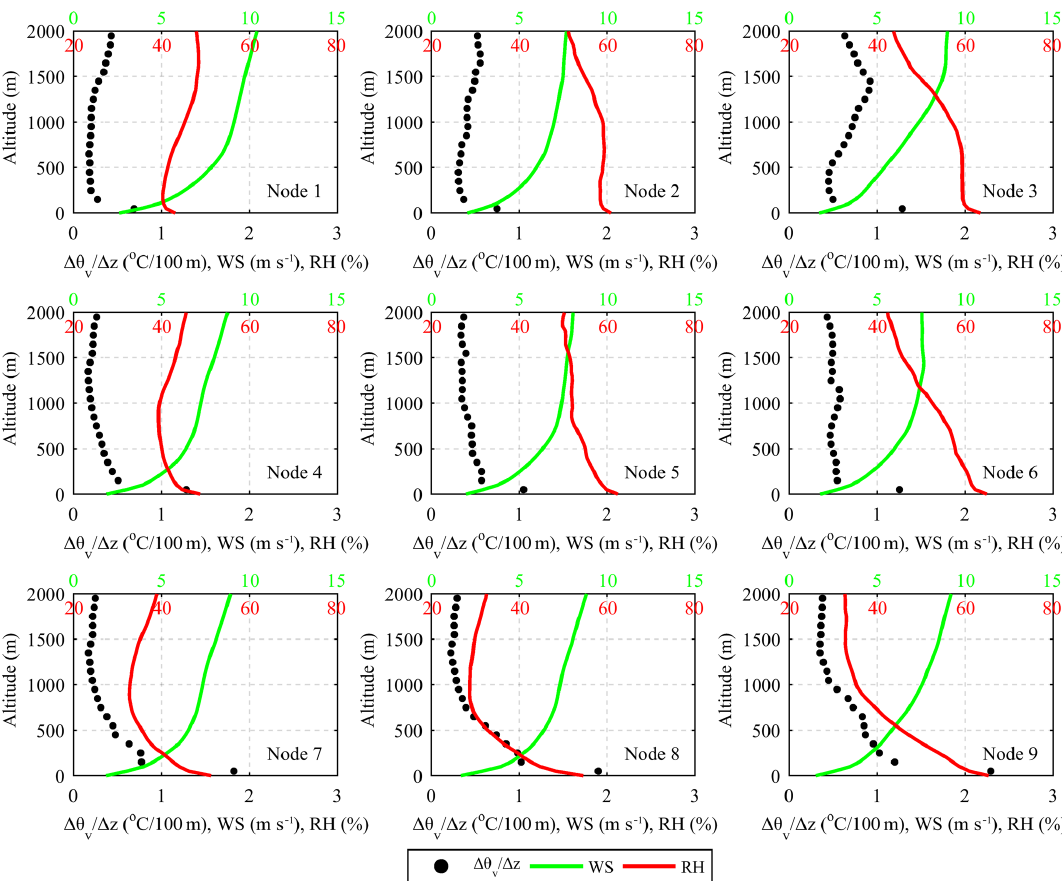
Figure 3. Profiles of average wind speed (WS), relative humidity (RH) and virtual potential temperature gradient ( (cid:49)θ v /(cid:49)z ) corresponding to individual ABL types (i.e., SOM nodes) at the Beijing Observatory. The black, green and red labels of the horizontal axis correspond to (cid:49)θ v /(cid:49)z , WS and RH, respectively.